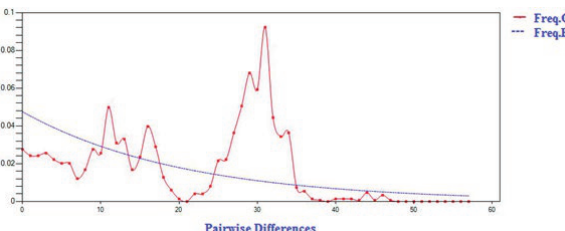
Figure 11. Mismatch plot of ITS sequences in Avicennia species.